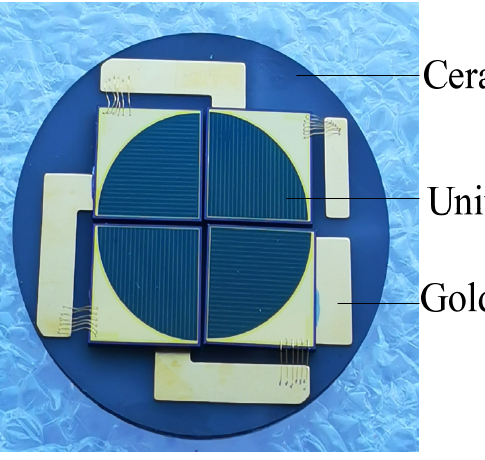
Figure 10. GaAs PV array converter.